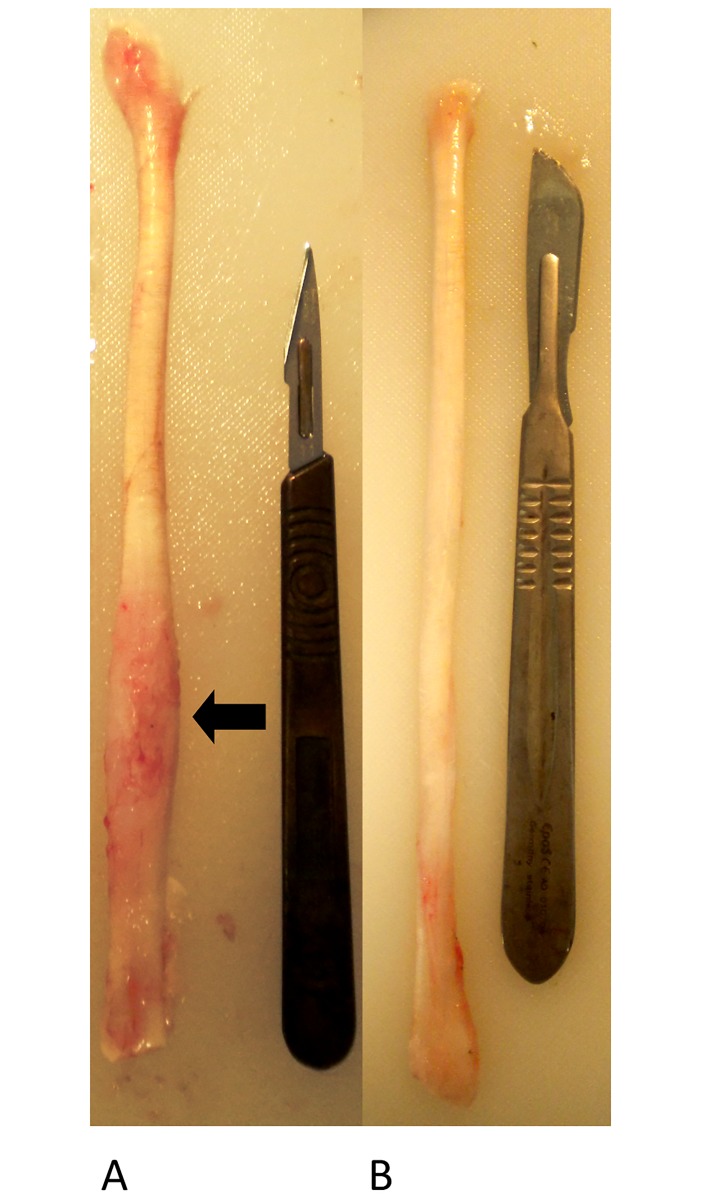
Representative sample of transected tendon (A) and control tendon (B).In comparison to control tendon, the transected tendon is visibly thickened and pink in colour distally in the regions surrounding the transection. The area of the lesion is poorly demarcated (arrow).